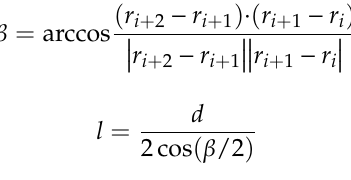
Figure 5. Preprocessing schematic diagram.